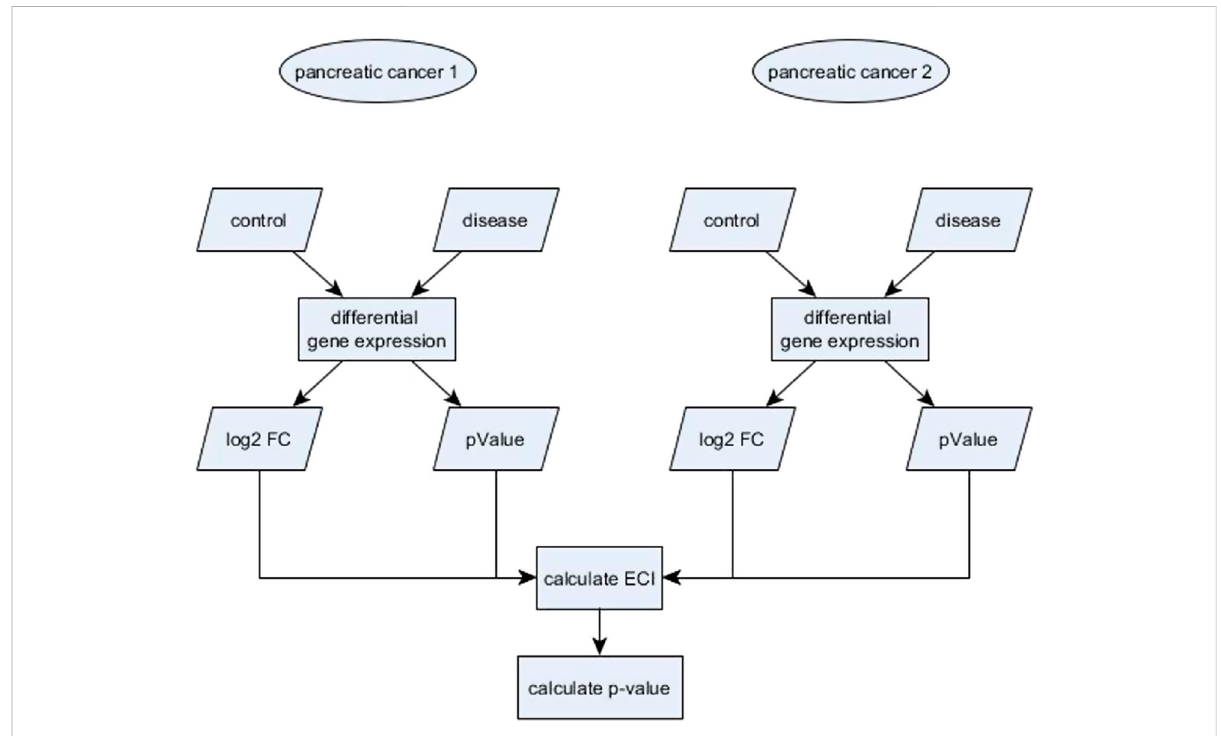
FIGURE 1 Work fl ow to compare the differential gene expression of genes of two different studies using the Equivalent Change Index